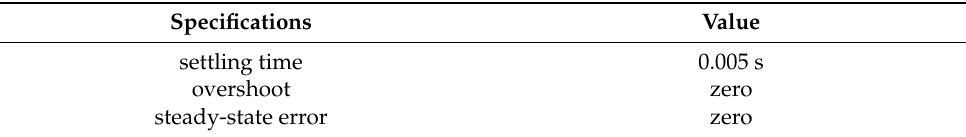
Table 3. Yaw rate controller design specifications.